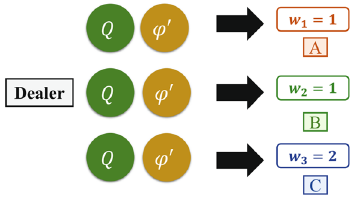
Figure 3. The dealer sends encrypted quantum particles and decoy particles.